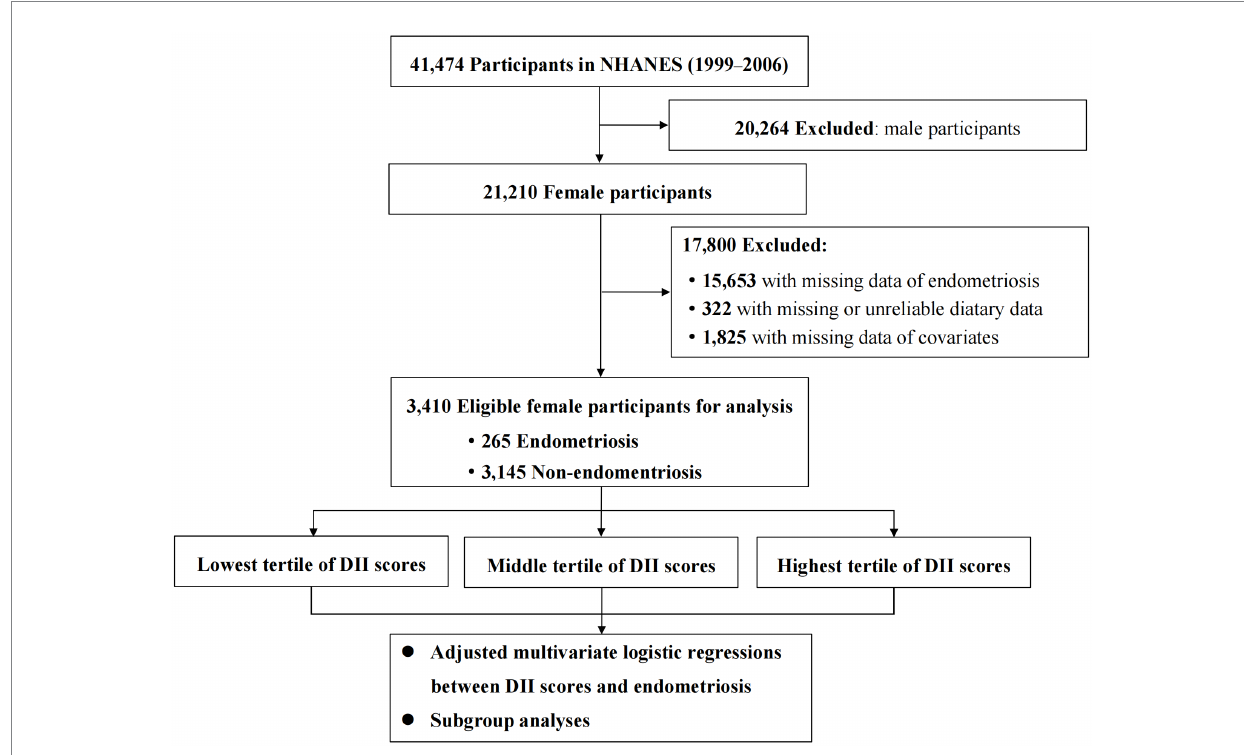
FIGURE 1 The flowchart of this study. NHANES, National Health and Nutrition Examination Survey; DII, dietary inflammatory